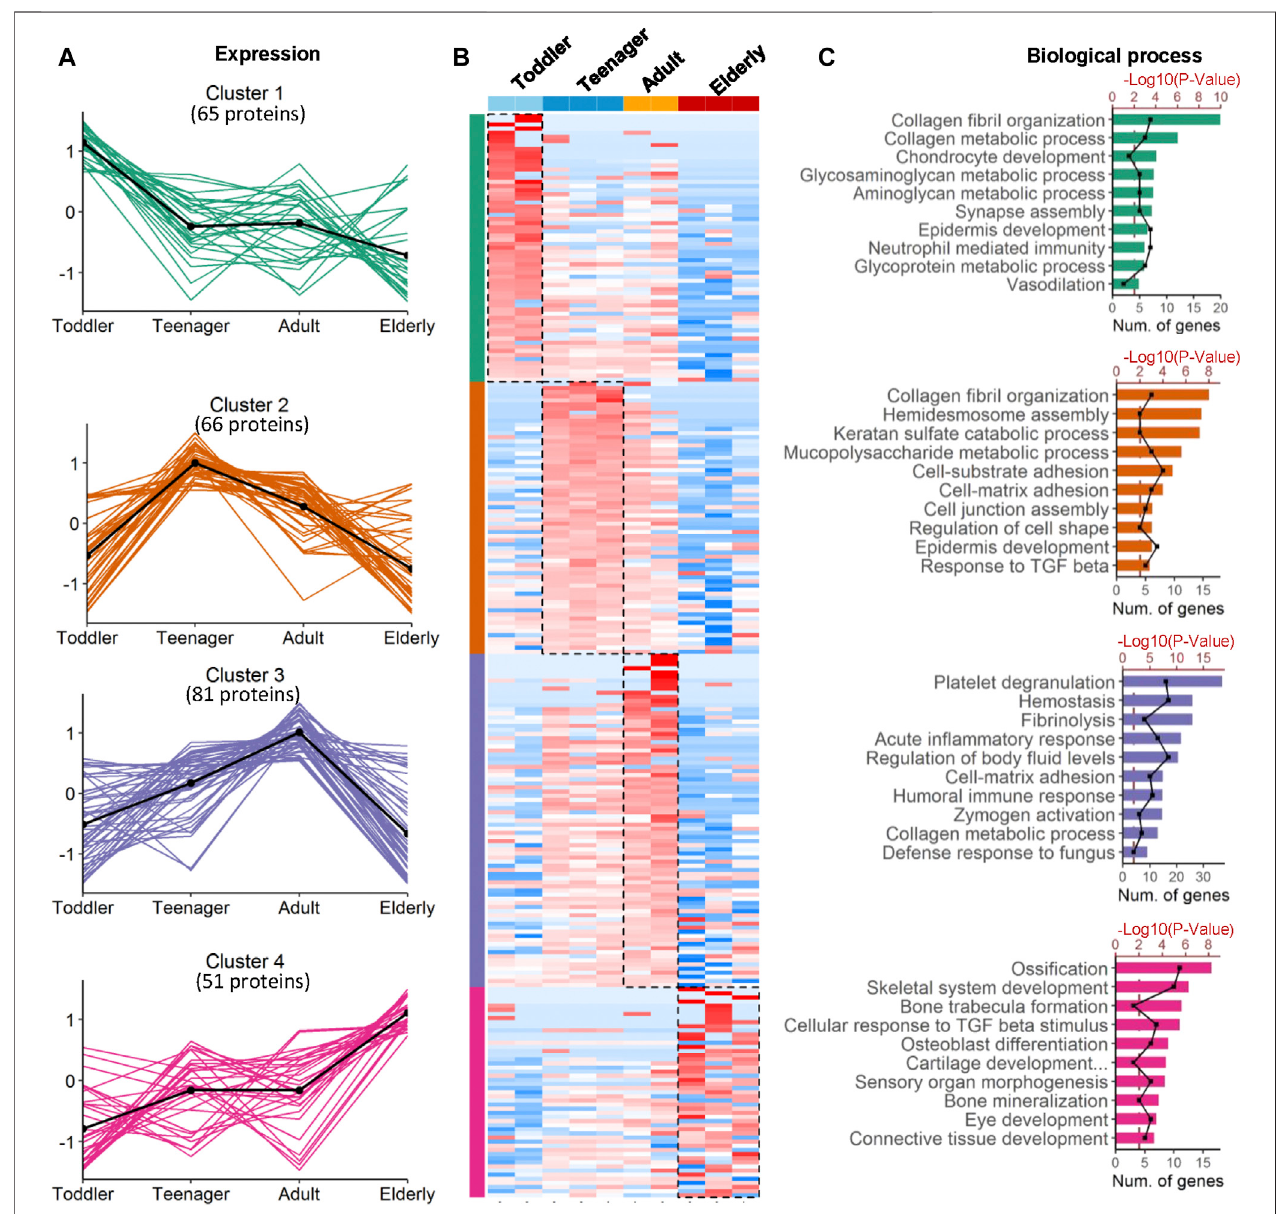
FIGURE 2 | Coexpression analysis of age-speci fi c ECM protein modules. (A) Four protein modules revealed ECM speci fi city based on age stage. Cluster 1 − 4 are theproteingroups highly expressed intoddler,teenager,adultand elderly, respectively. (B) Heatmap analysisofECMidenti fi edinsamplesfromskin bioscaffolds offour ages (toddler, teenager, adult, and elderly) according to log 2 normalized protein intensity. Red and blue boxes indicate proteins with increased and decreased abundance, respectively. Green, purple, and rose bars correspond to the proteins enriched in skin bioscaffolds from toddler, teenager, adult, and elderly. (C) Clusters of proteins associated with similar biological process were grouped according to the degree of enrichment.